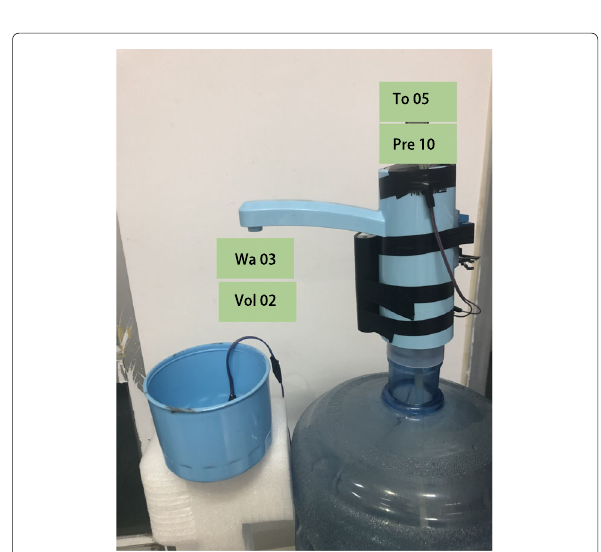
Fig. 3 A water machine model of multi-modeling